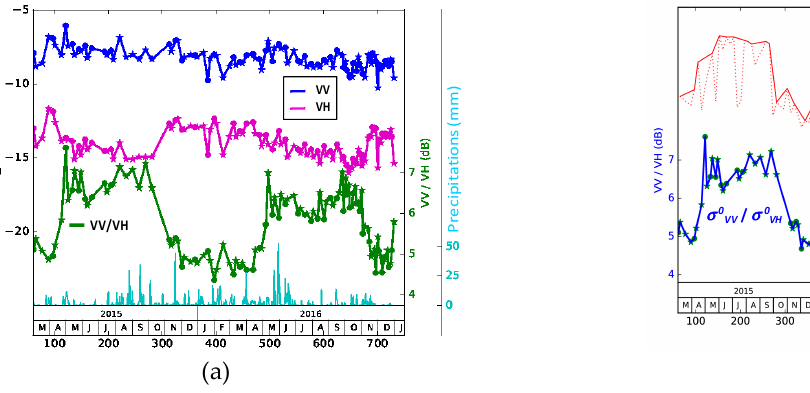
, σ 0 , and σ 0 / σ 0 are VV VH VV VH / σ 0 VV VH